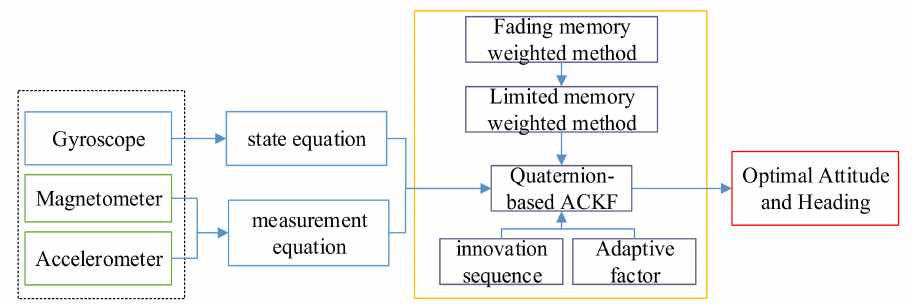
Figure 3. The frame of the quaternion-based adaptive cubature Kalman filter (ACKF)